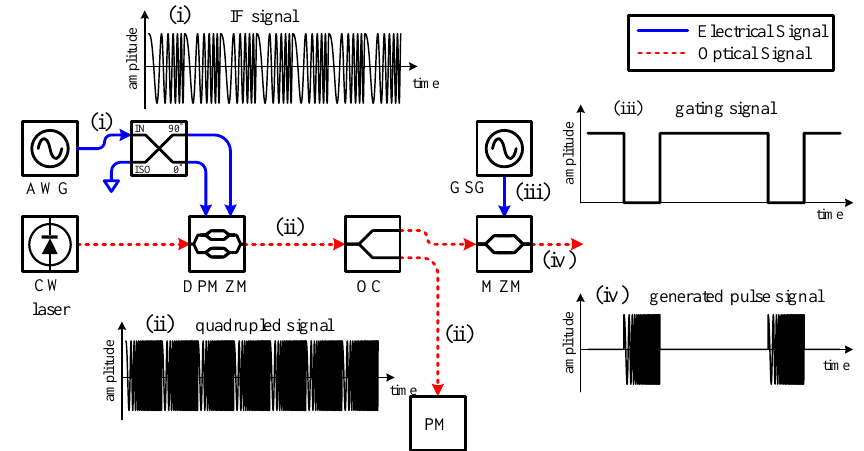
Figure 2. Signal waveforms for each node in the proposed architecture in the time